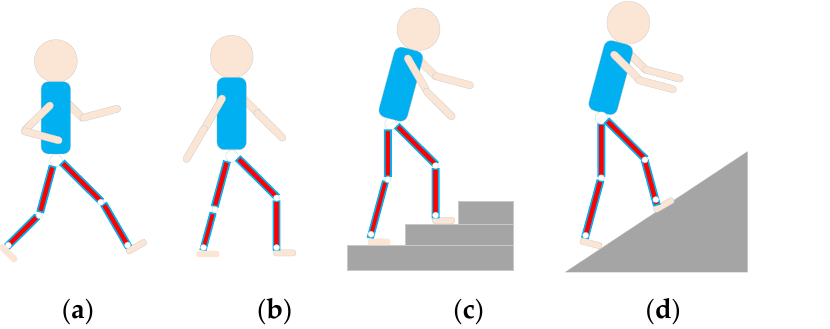
Figure 3. Four daily patterns of human movement. ( a – d ) represent running, level ground walking, stair ascent and ramp ascent.